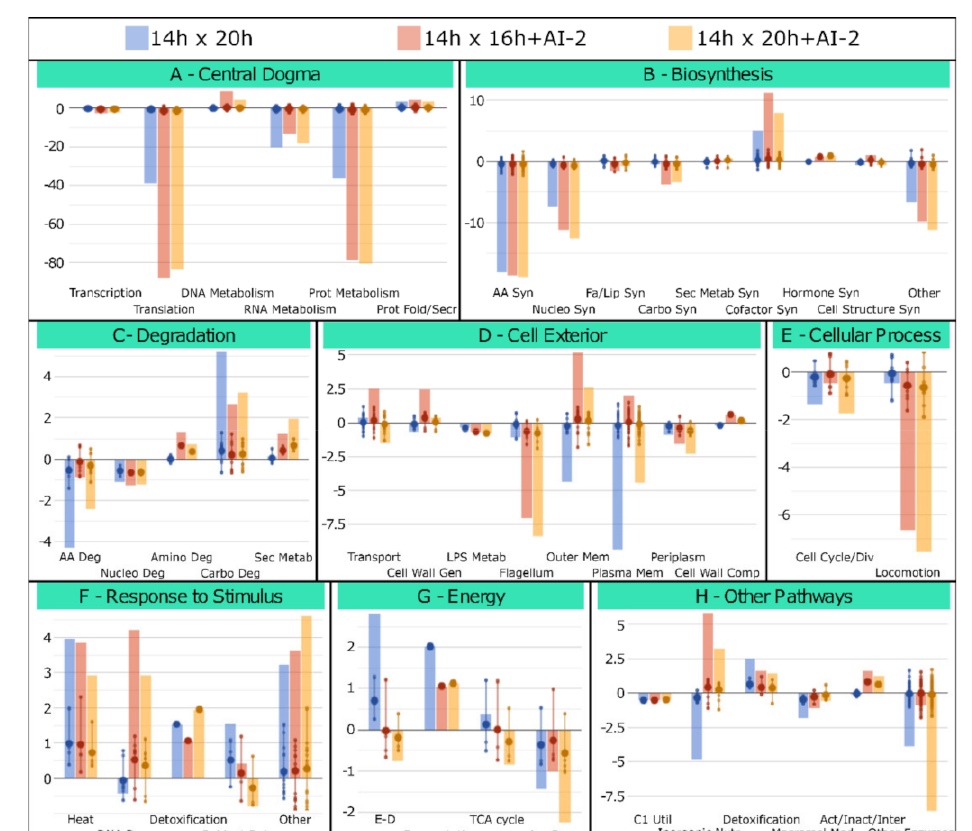
Figure 3. Functional distribution of differentially modulated genes. The OMICS Dashboard tool, available through the Pathway Tools package, was used to distribute the 724 genes shown in Figure 2 into the 8 main functional/structural systems/subsystems defined in the ZM4 Pathway Genome Database (PGDB), available at BioCyc (panels A to H ) (see text, for details). Total modulation of the different categories is shown by the sum of relative expression (Log2 ratios) for all genes present in each system/subsystem. Details regarding each gene present in each functional/structural category can be found in Supplementary Materials File